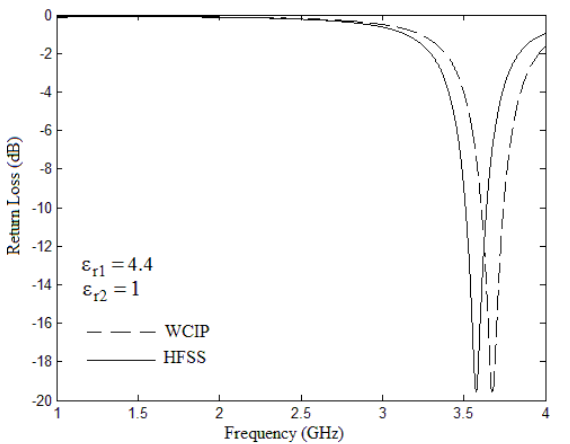
Figure 4: Return loss versus frequency for suspended microstrip rectangular patch antenna.